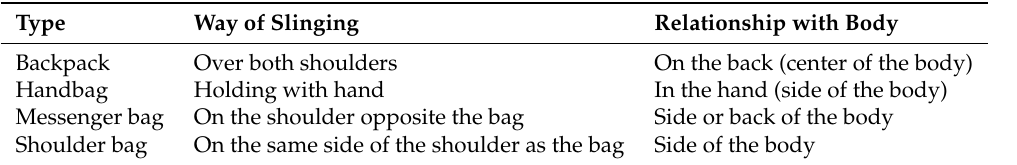
Table 2. Characteristics of the four types of